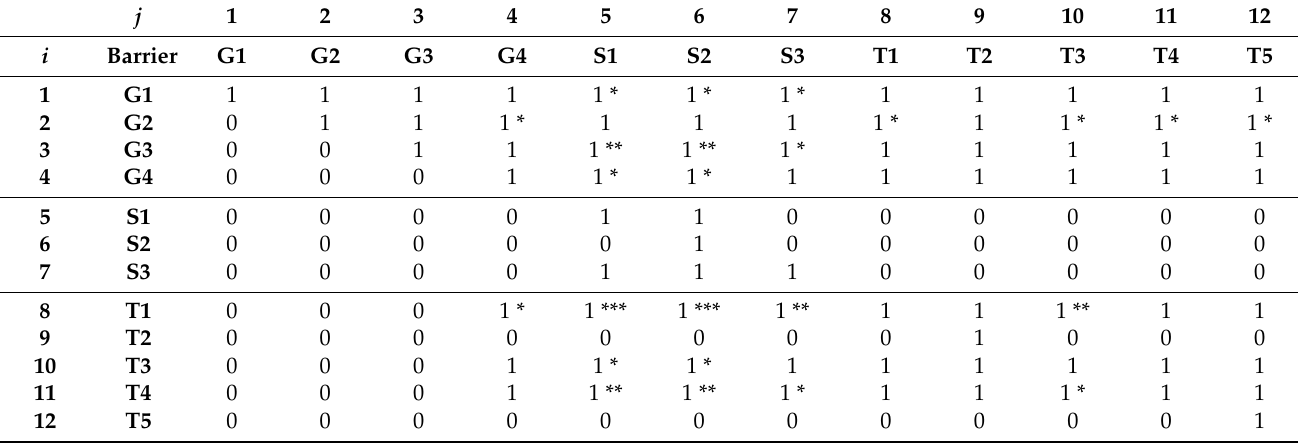
Table 6. Final Positive Reachability Matrix (+RM fin